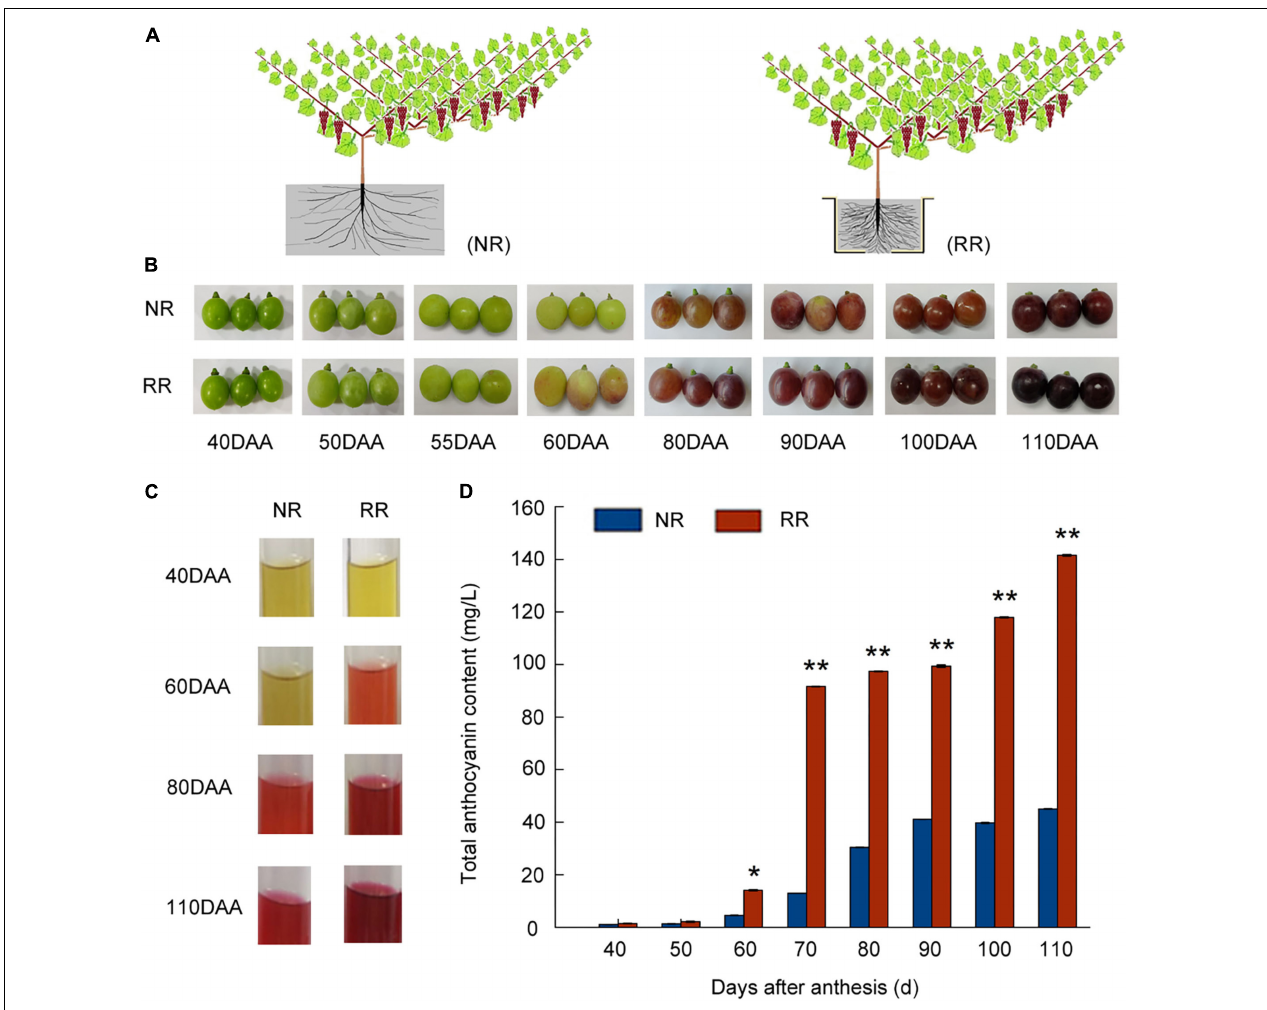
FIGURE 1 | Effects of root restriction cultivation on fruit development and anthocyanin accumulation during grape berry development: (A) model of root restriction (RR) and no root restriction cultivation (NR, control); (B) process of berry development in grape berries under root restriction cultivation (RR) and no restriction cultivation (NR, control); (C) anthocyanin staining; and (D) relative anthocyanin contents of grape berries under root restriction (RR) and no root restriction (NR) cultivation. Three biological replicates were performed. Lines graphs and error bars represent average and SE, respectively. Asterisks represent different level of significance ( P ≤ 0.05*, P ≤ 0.01**), and significant differences are indicted by different lowercase letters based on independent sample t